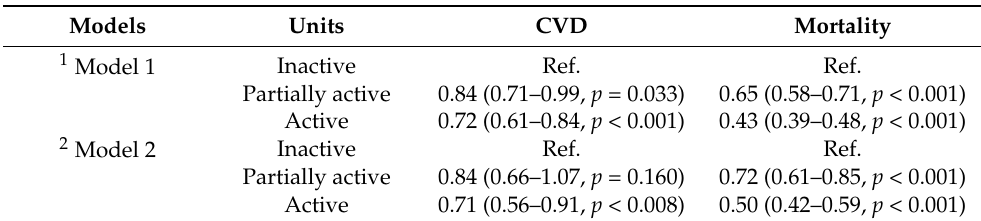
Table 4. Unadjusted and adjusted ORs (95% CI) of CVD and mortality according to physical activity among subjects with Type 2 diabetes in the case–control